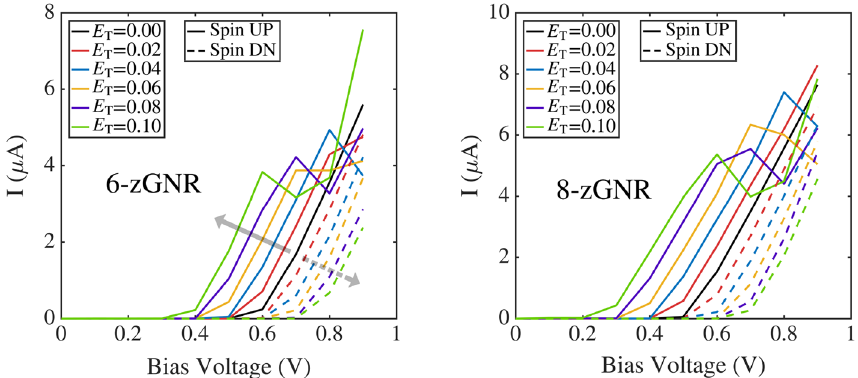
Figure 2. External field effects on the I–V characteristic curves of zGNRs with antiferromagnetic initialization (6-zGNR left, 8-zGNR right). Colors indicate different transverse fields, in units of of V / Å . The solid lines represent spin up current, while the dashed lines represent spin down current. Gray arrows indicate the trends associated with increases in the magnitude of the transverse electric